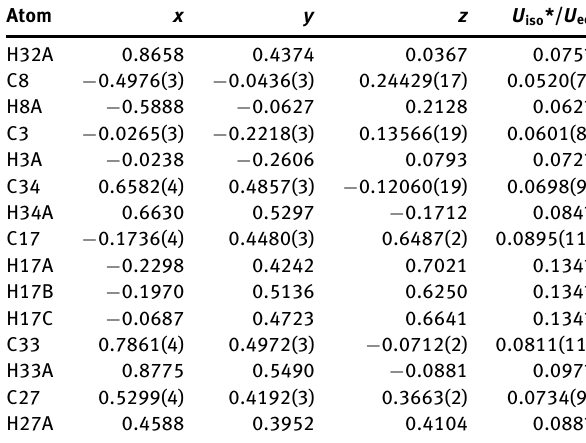
Table 2: Fractional atomic coordinates and isotropic or equivalent isotropic displacement parameters (Å 2